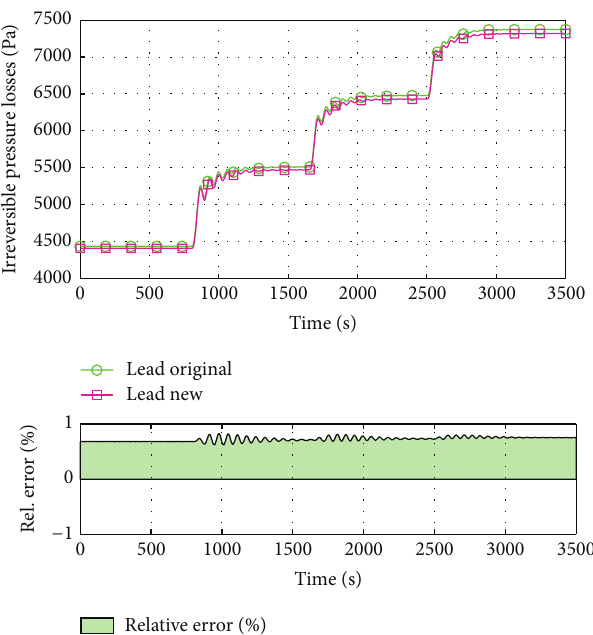
Figure 28: Lead system irreversible pressure losses, original versus new “tpf”